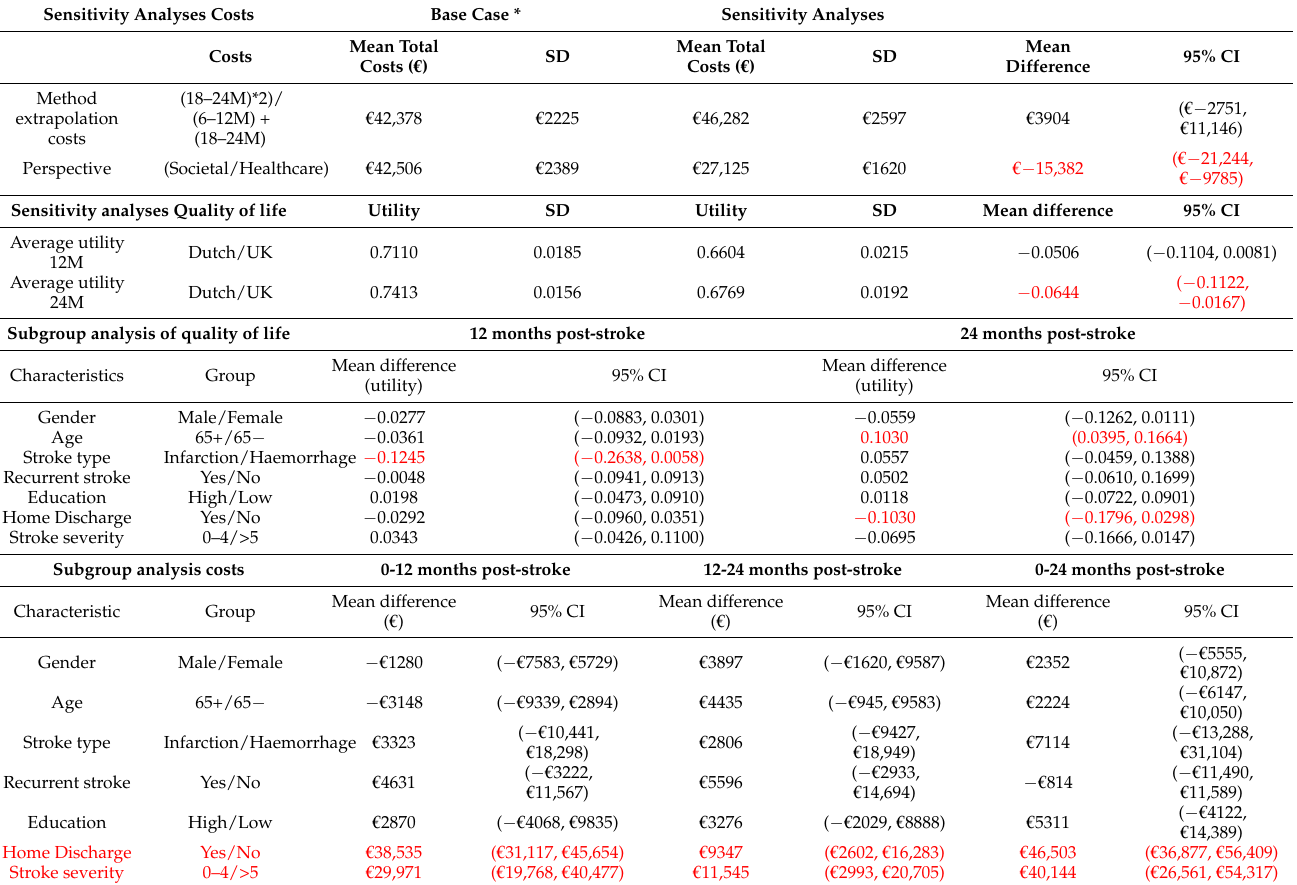
Table 5. Sensitivity and Subgroup analyses.